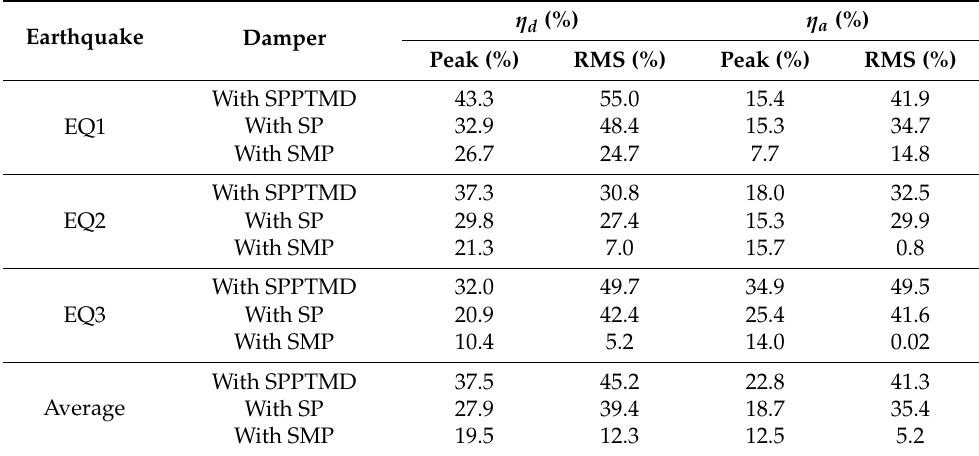
Table 2. Vibration reduction ratios of the transmission tower.